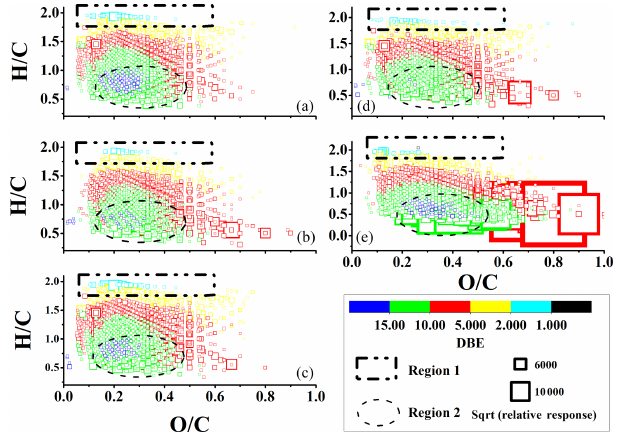
Figure 2. The Van Krevelen (VK) diagrams of CHO compounds for off-road engines. Panels (a), (b), (c), (d) , and (e) were the mass spectra for excavators in idling, working, and moving modes and vessels using diesel and HFO,